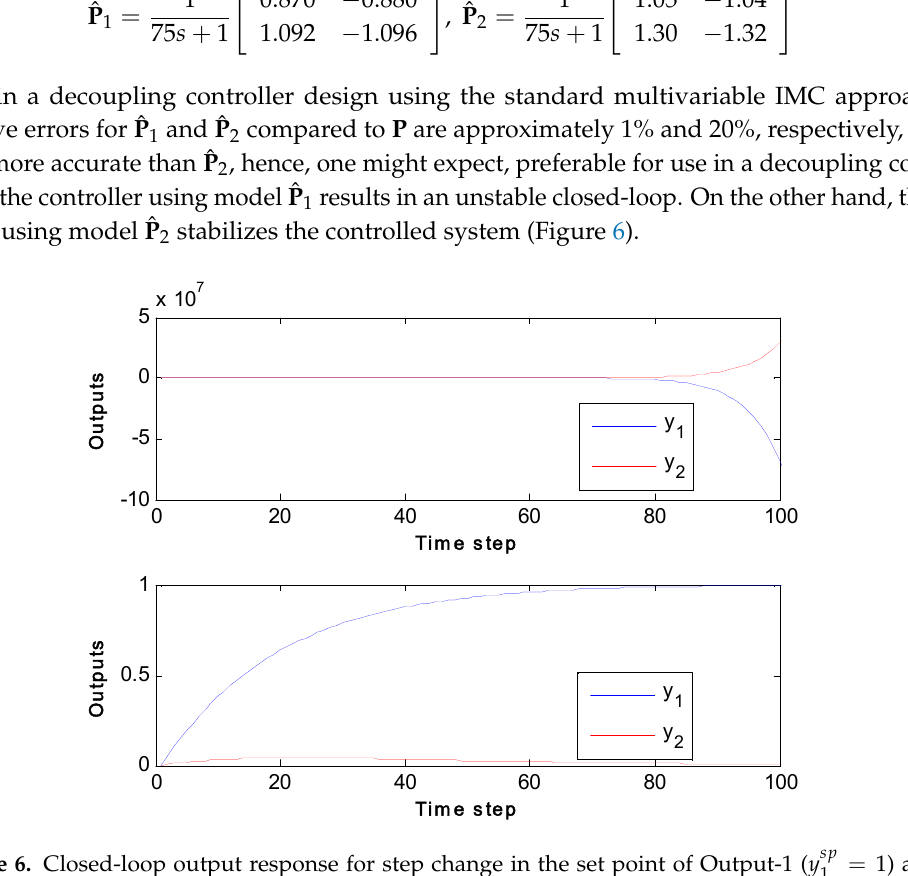
= 0) using controllers based on model ˆ P 2 0 sp y  ) using controllers based on model (cid:1790)(cid:3553) (cid:2869) (top) and (cid:1790)(cid:3553) (cid:2779) 2